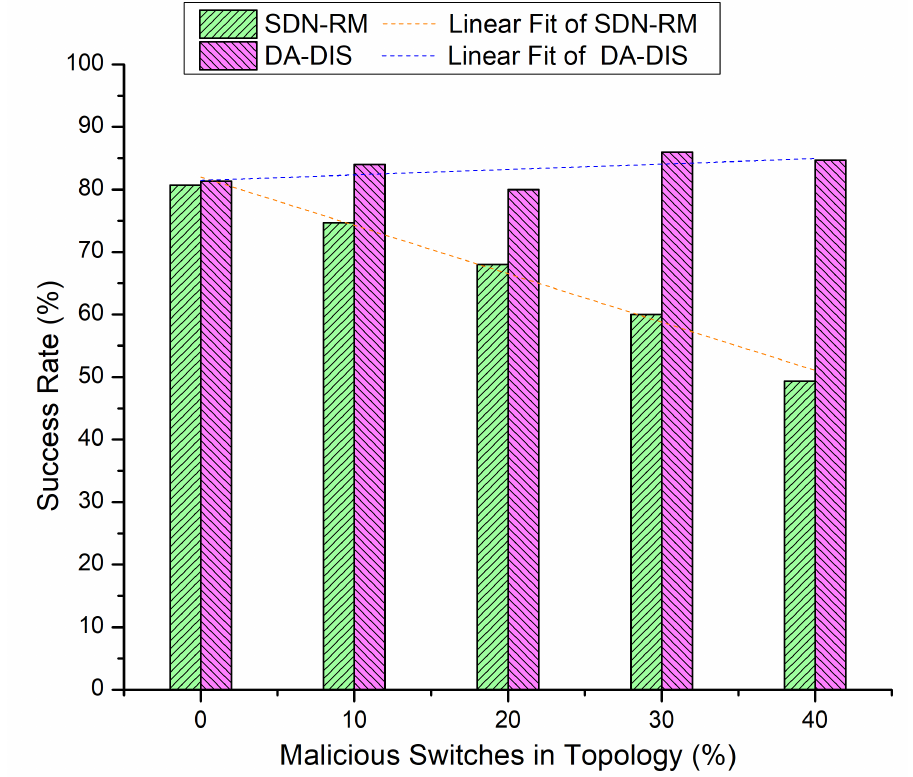
Figure 9. Success rate considering different numbers of malicious switches with E1 category